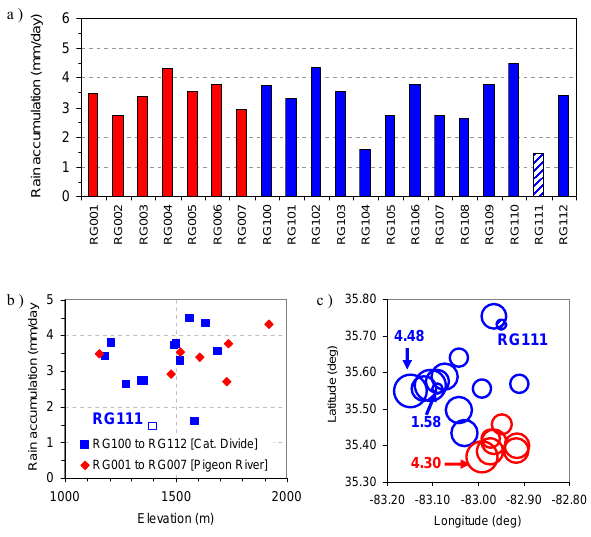
Fig. 2: a) Average rain accumulation (mm/day) for the rain gauges deployed in the GSMNP. Average rain accumulation as a function of: b) Elevation. c) Geolocation of each rain gauge. The size of the symbols represents the average daily rain accumulation (mm/day).